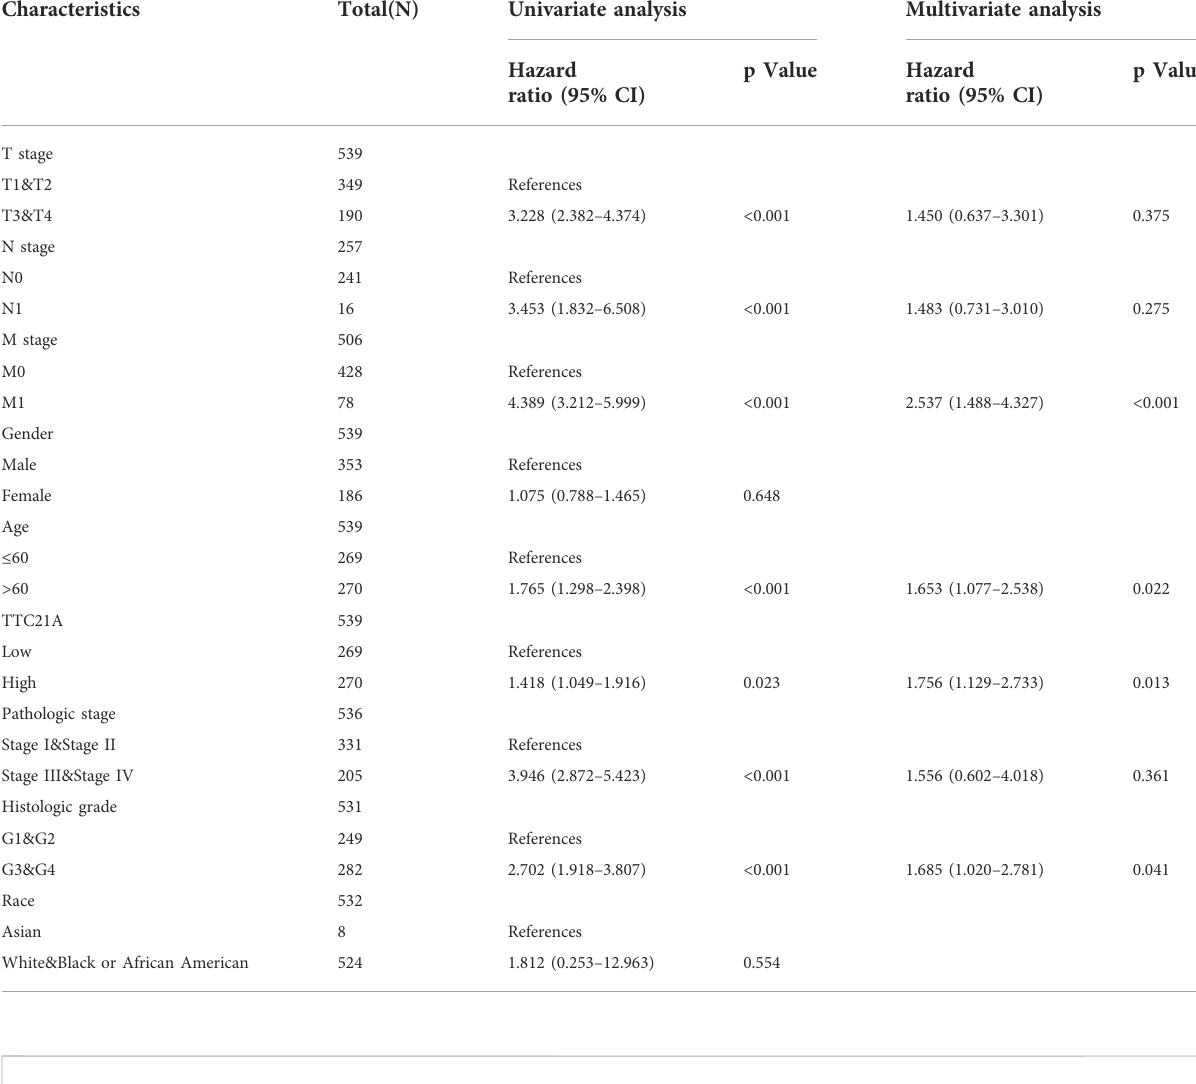
TABLE 2 Univariate and multivariate Cox analyses of OS in ccRCC patients.